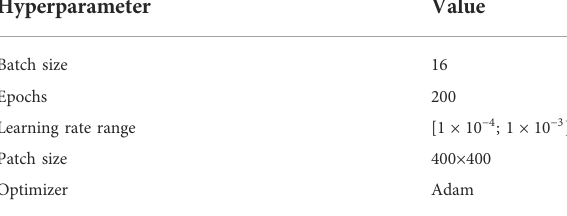
Table 2. The designed network consists of four stages, and the feature extraction of each resolution in every stage is completed by four residual convolution operations. With the fi nal integration of the feature maps obtained on each resolution, noise suppression and high-resolution signal reconstruction can be completed.